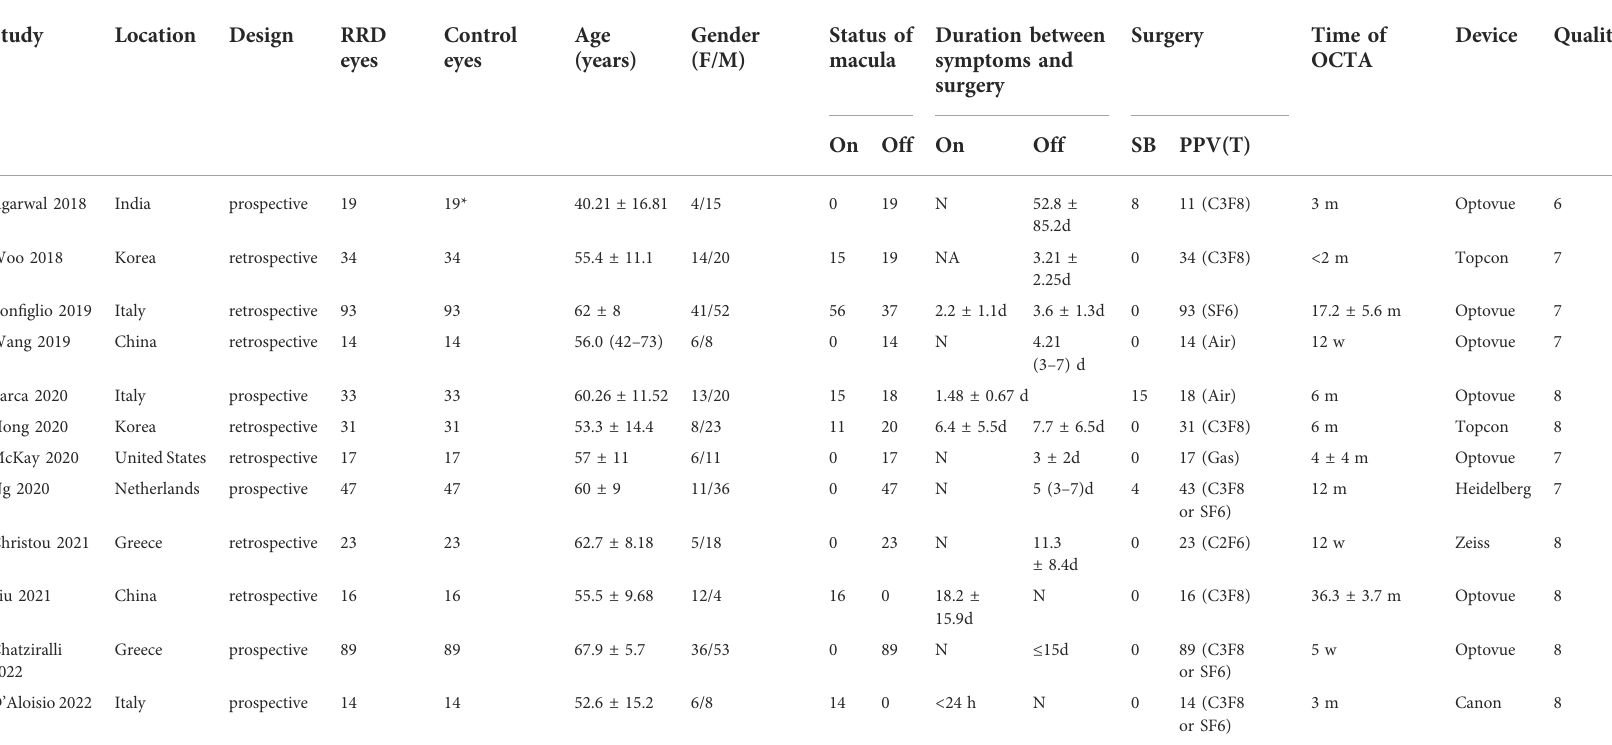
TABLE 1 The characteristics of included